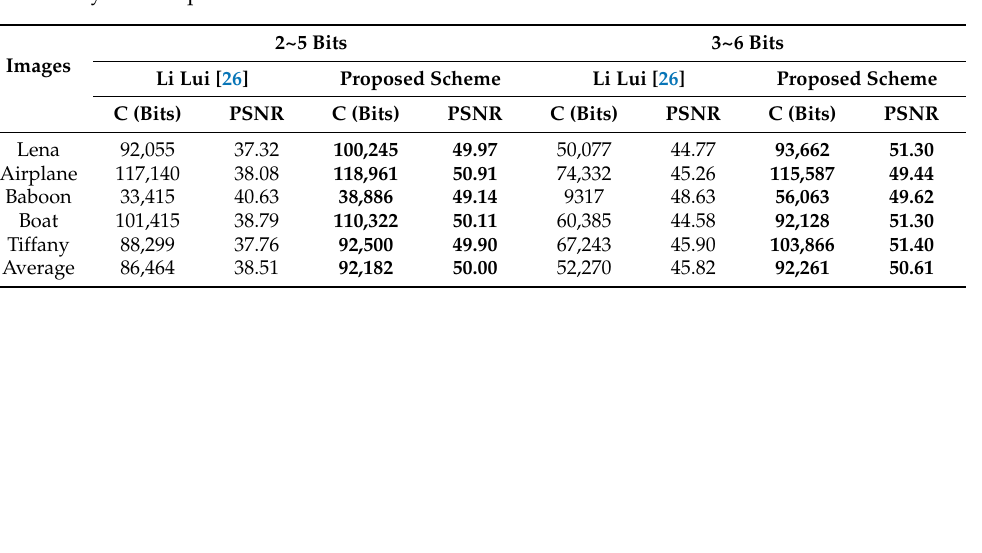
Table 4. Comparison of performance by selecting 4 bit-planes. Bold values shows the best results achieved by the compared